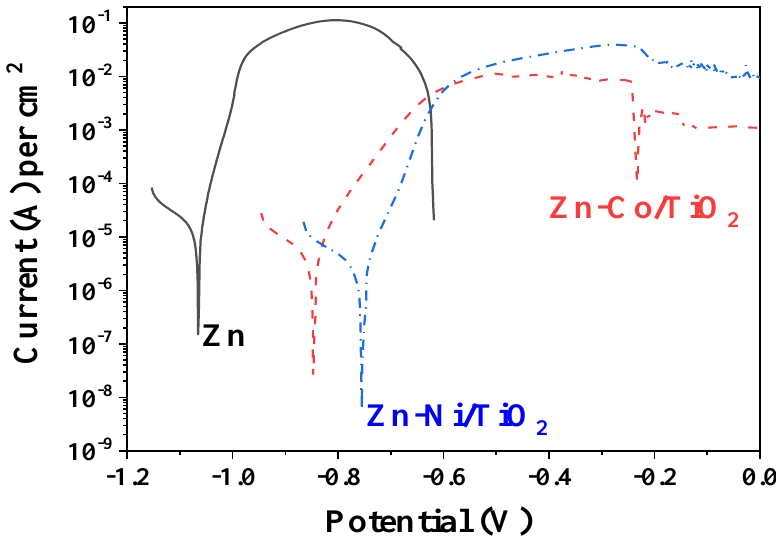
Figure 11. PDP curves of ordinary Zn, System A (Zn-Ni/TiO 2 ) and System B (Zn-Co/TiO 2 ).